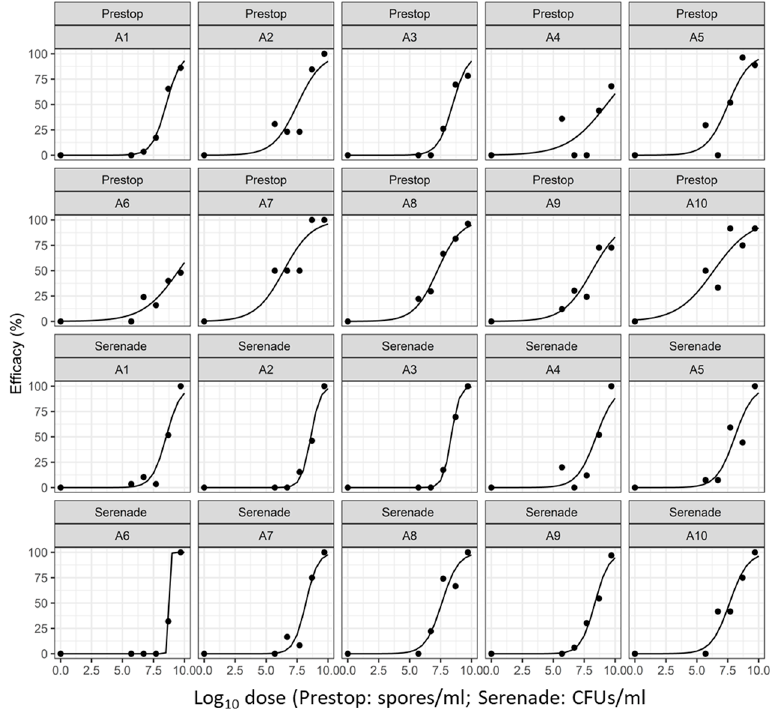
Figure 6. The effect of leaf position on the biocontrol efficacy on L. sativa leaf discs from attached lettuce leaves pre-inoculated with B. cinerea and then challenged with two biocontrol products (Prestop and Serenade) at different doses in a glasshouse at 17–22 ◦ C with a RH range of 60–100%. Curves are fitted logistic models describing the observed dose-response relationships. The exact leaf positions are given in Figure 1.